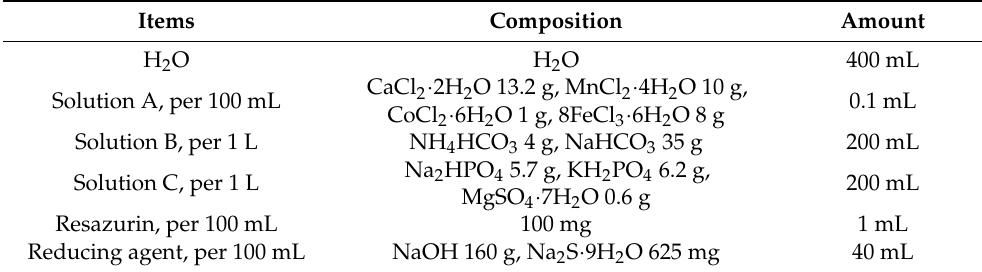
Table 3. Composition of culture medium in fermentation